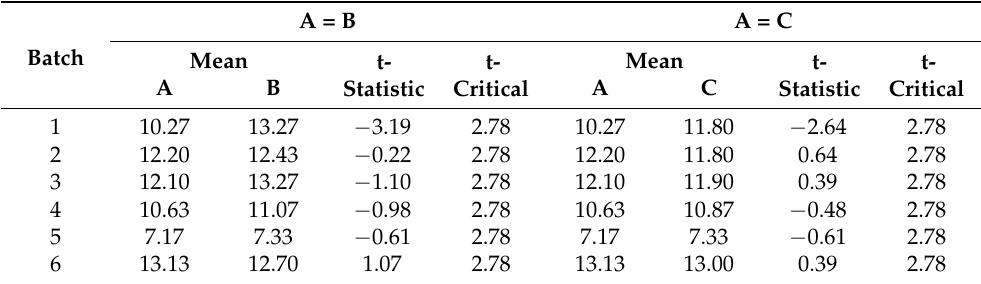
Table 3. Student’s t -test to determine the compressibility behavior of the assembled co-processed excipients.